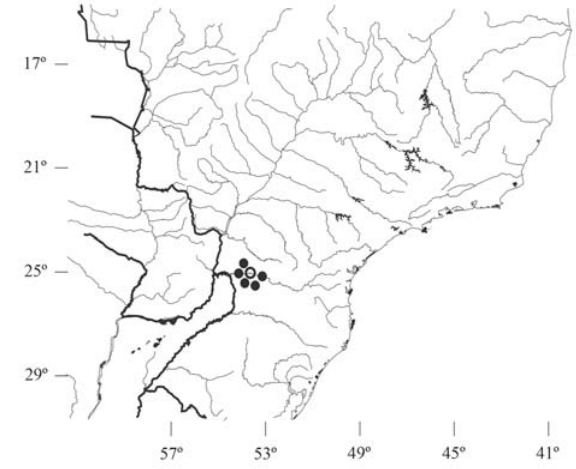
Fig. 3. Map of southeastern Brazil and adjoining regions, showing the type-locality of Tatia jaracatia (circle), rio Jaracatiá, and the geographical distribution of the species (dots), lower rio Iguaçu basin. Both symbols represent more than one lot and/or